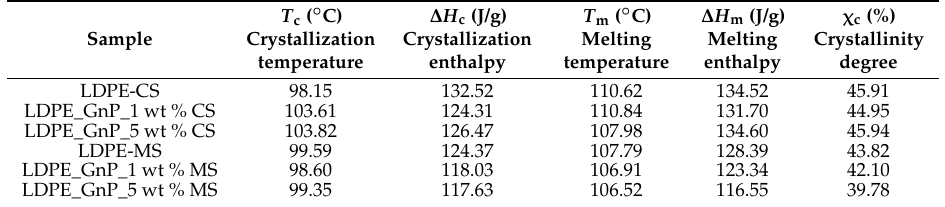
Table 3. Basic characteristics of the low density polyethylene and GnP nanoplatelets as a filler.